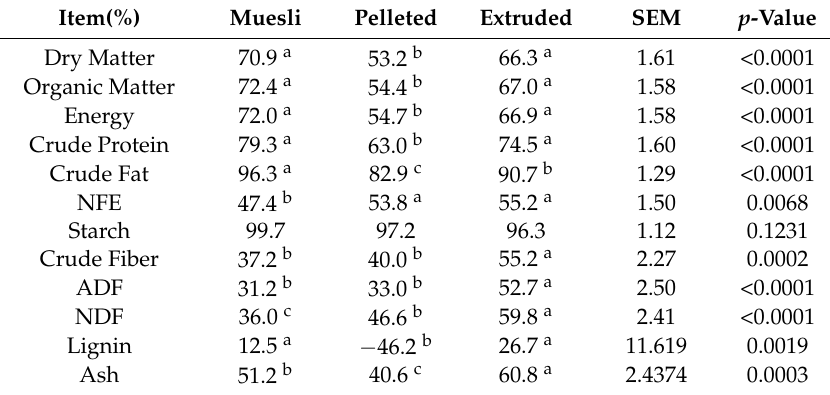
Table 4. Apparent total tract digestibility of muesli, pelleted, or extruded dietary treatments fed to rabbits and determined by total fecal